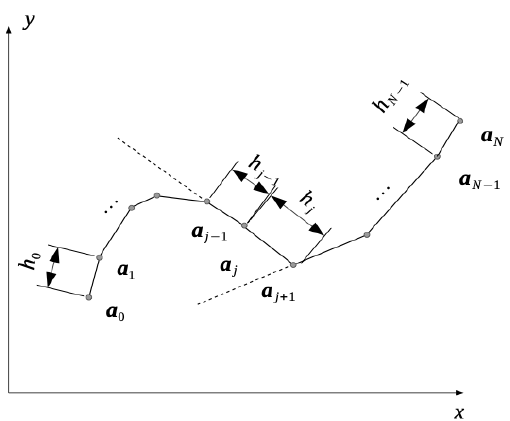
Figure 1. Broken line integration